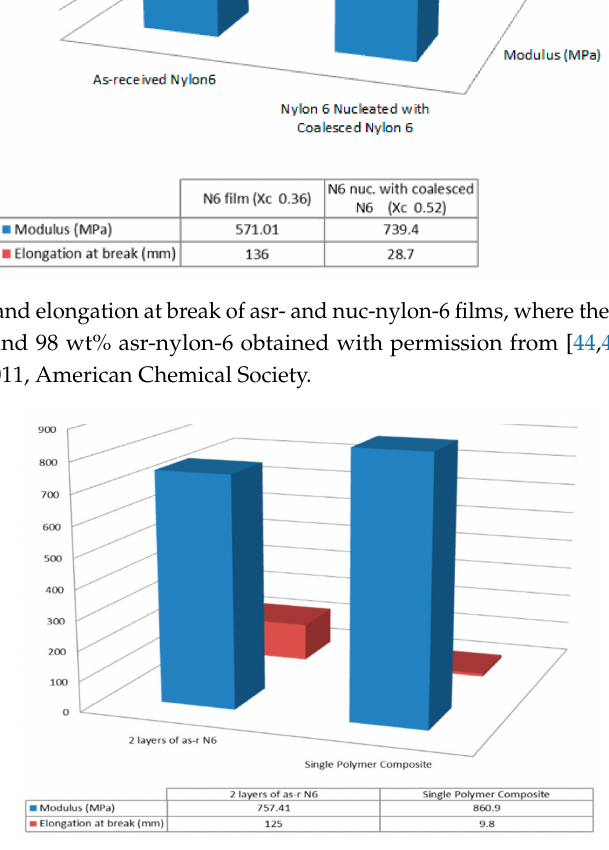
Figure 14. Moduli and elongation at break of melt pressed asr / asr and asr / nucl Nylon-6 film sandwiches. Reproduced with permission from [44]. Copyright 2005 American Chemical